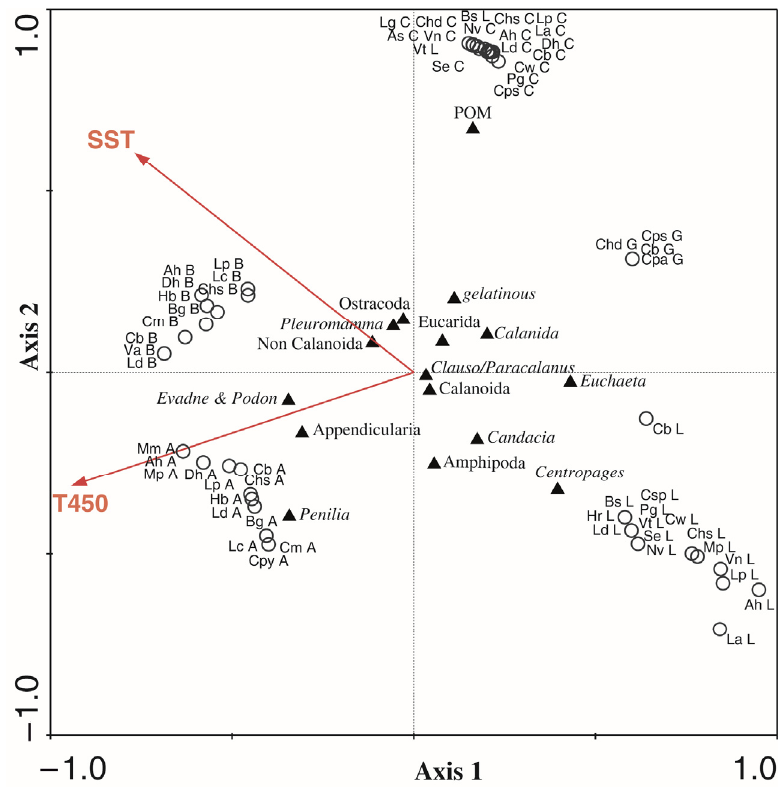
Figure 4. Canonical ordination plot (CCA) for the diet of mesopelagic species. The red arrows indicate the explanatory variables (SST: sea surface temperature; T450: temperature at the 450 m-depth strata; and FI: integrated fluorescence in the first 200 m of the water column). Labels with two or three letters indicate the species name, and the separated upper-case letter indicates the zone (B: